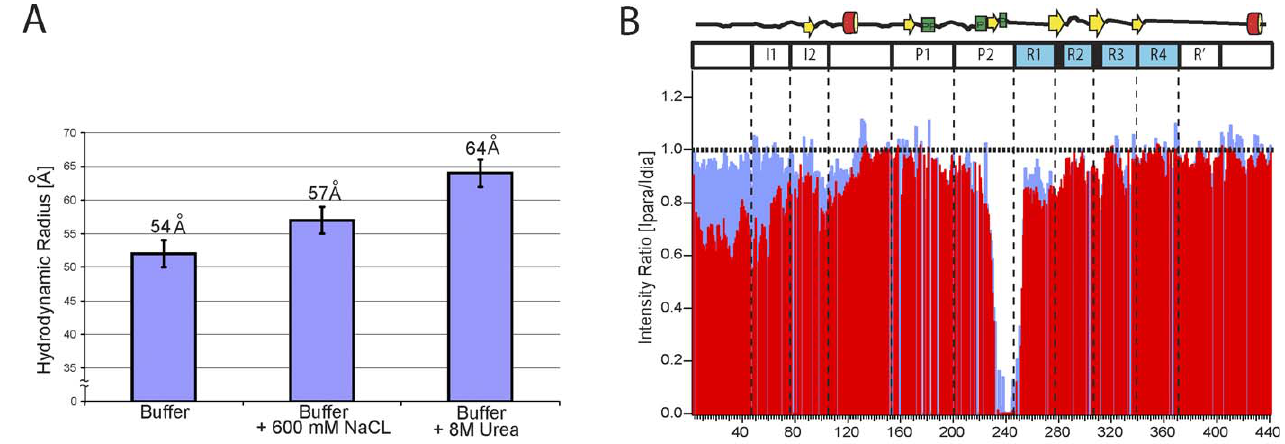
Figure 9. Influence of Ionic Strength and Urea on Intramolecular Long-Range Interactions (A) Hydrodynamic radius values of htau40 in buffer (99.9 % D 2 O, 50 mM phosphate buffer [pH 6.9]), upon addition of 600 mM NaCl and in the presence of 8 M urea. (B) PRE profiles of amide protons in spin-labelled htau40 in buffer (red bars) and in the presence of 600 mM NaCl (blue bars). The single-cysteine mutant A239C was labelled with MTSL. Intensity ratios were averaged over a three-residue window.